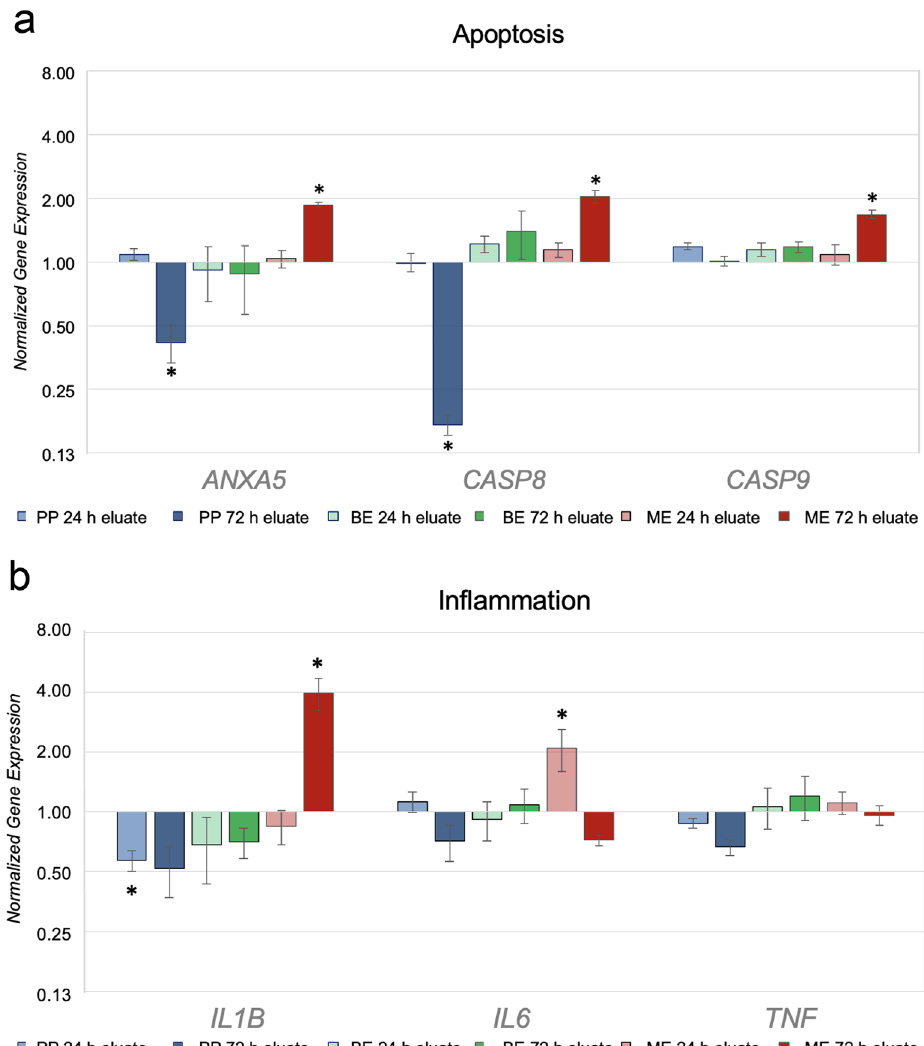
Figure 6. Normalized up-/down-modulation of selected genes of apoptosis ( a ) and inflammation ( b ) in HGK exposed to 24 h and 72 h eluates from PP, BE and ME for 72 h referring to the untreated control. Data are normalized to the untreated control cells and the unregulated housekeeping genes GAPDH , RPL13A and UBC . The normalized expression was calculated using the 2 −ΔΔCT method 29 . Asterisks (*) indicate significance ( p < 0.05) compared to the untreated